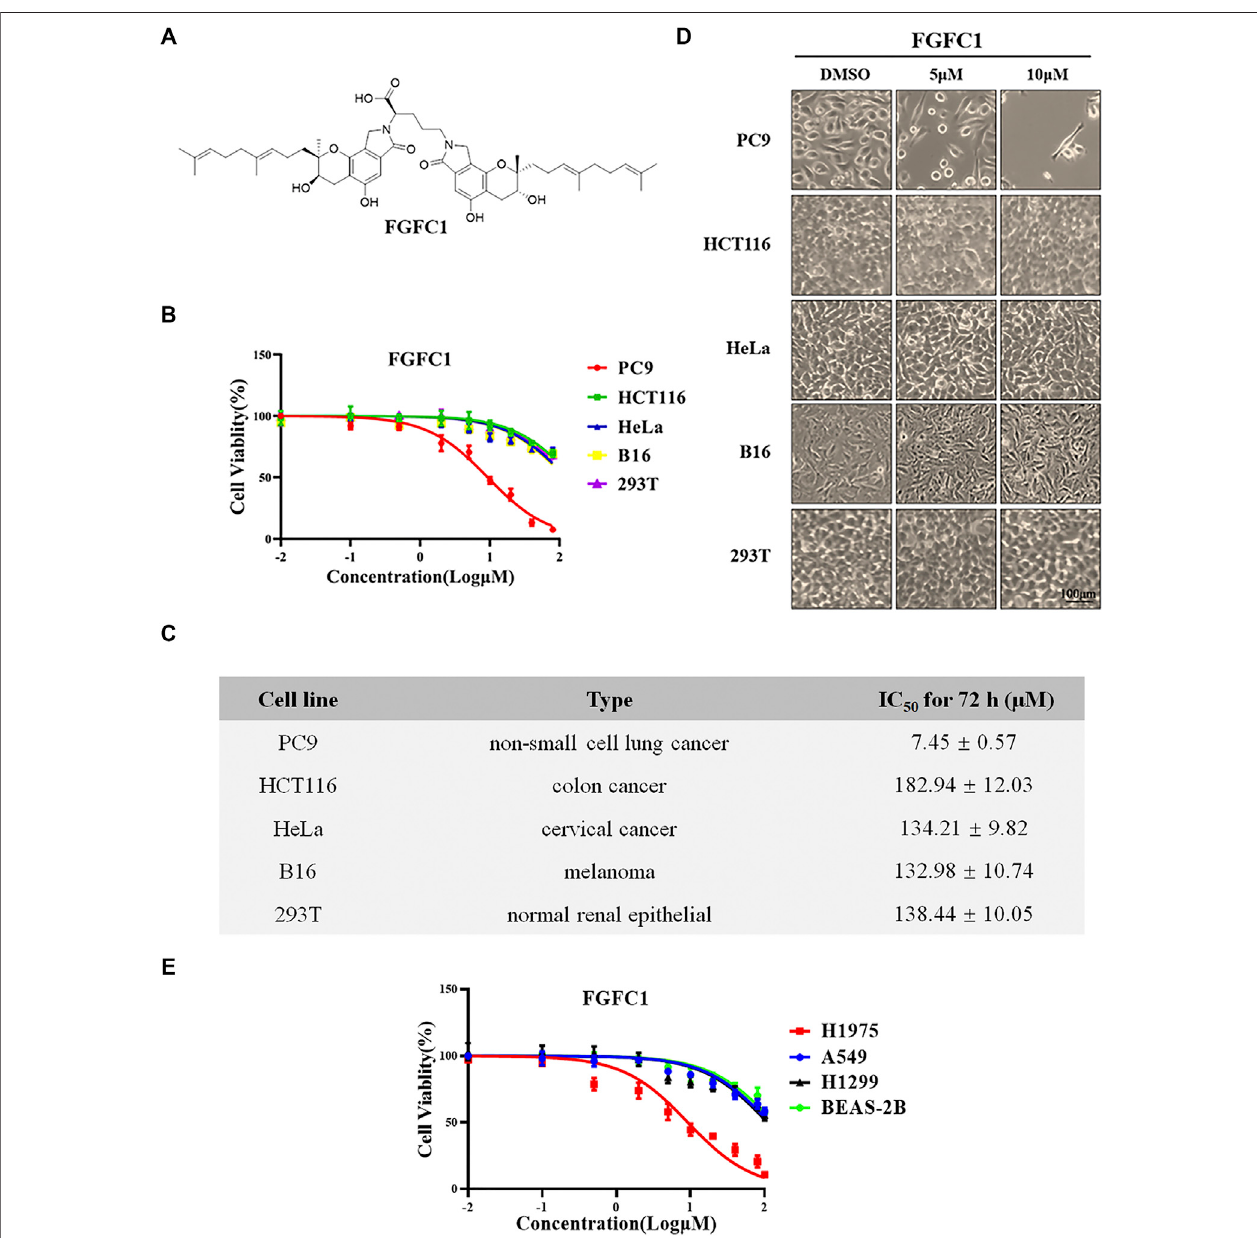
FIGURE 1 | The cytotoxic effects of FGFC1 on different cancer cells. (A) Chemical structure of FGFC1 (MW (cid:1) 869.4947). (B) NSCLC cell lines (PC9) were more sensitivetoFGFC1thantheotherfourcelllinesfor72 h.PC9,HCT116,HeLa,B16,and293TcellswereincubatedwiththeindicatedconcentrationsofDMSOorFGFC1 (0.01,0.1,1,2,5,10,20,40,80,and100 μ M)for72 h.Cellviabilitywasassessed usingCCK-8 assayandshown asrelative viabilitycompared totheuntreated control. Each test was performed in triplicate. (C) The IC 50 values of FGFC1 in PC9, HCT116, HeLa, B16, and 293T cells were assessed and expressed as the mean ± SD ( n (cid:1) 3). (D) Above described cells were treated with different concentrations of FGFC1 (0, 5, and, 10 μ M) for 72 h. Cell morphology was imaged under microscope (200 × ). Scale bar (cid:1) 100 μ m. (E) FGFC1 selectively inhibited the growth of H1975 erlotinib-resistant NSCLC cells in a dose-dependent manner. H1975, A549, H1299, and BEAS-2B cells were treated with FGFC1 (0.01, 0.1, 1, 2, 5, 10, 20, 40, 80, and 100 μ M) for 72 h, respectively. Cell viability was examined by CCK-8 assay and shown as relative viability compared to the untreated control. Each test was performed in triplicate. (F) The IC 50 values of FGFC1, the EGFR mutations status, and the erlotinib sensitivity of these four cells were assessed and expressed as the mean ± SD ( n (cid:1) 3). (G) H1975, A549, H1299, and BEAS-2B cells were treated with different concentrations of FGFC1 (0, 5, and 10 μ M) for 72 h. Cell morphology was imaged under microscope (200 × ). Scale bar (cid:1) 100 μ m. (H) FGFC1 remarkably increased the LDH leakage of H1975 cells. The above described cells were incubated with the indicated concentrations of DMSO or FGFC1 (0, 5, 10, and 20 μ M) for 48 h. The cytotoxicity of FGFC1 on these cells was examined by the release of LDH. (I) FGFC1 signi fi cantly inhibited colony formation ability of H1975 cells in a dose-dependent manner. Colony formation of H1975 and A549 cells was monitored after FGFC1 (0, 5, 10, and 20 μ M) treatment for 14 days, and photographs of crystal violet stained coloniesweredepicted. (J) Thestatistical resultof (I) .All datawererepresented asthemeans ± SDforat leastthreeindependentexperiments. ( *p < 0.05and **p < 0.01 vs the DMSO